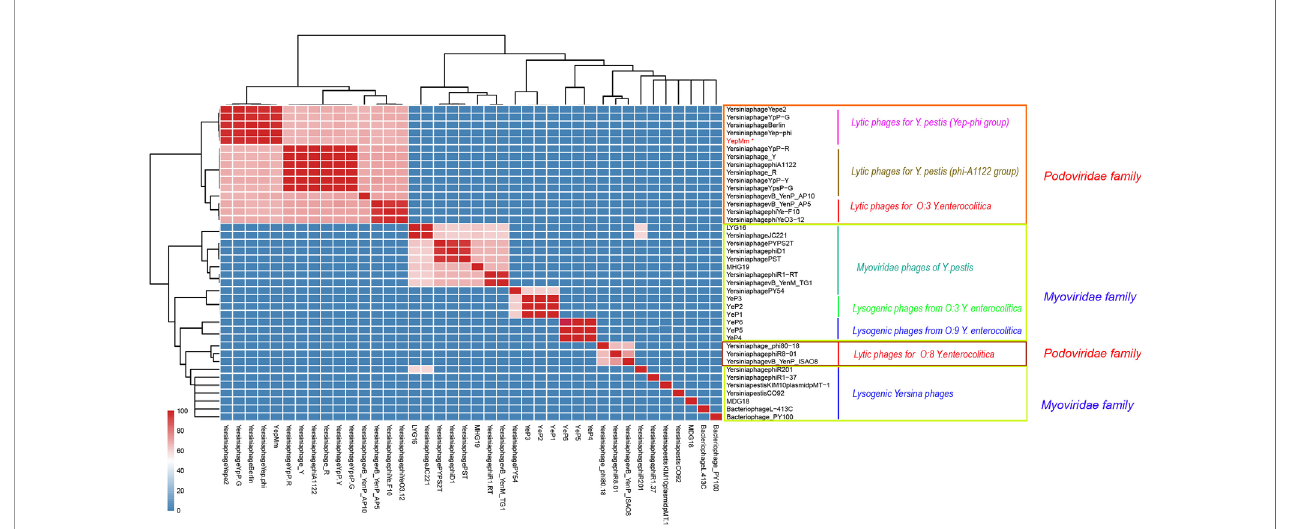
FIGURE 2 | Average nucleotide identity (ANI) matrix of phages. ∗ Indicates the lytic bacteriophage of Yersinia pestis in this study.